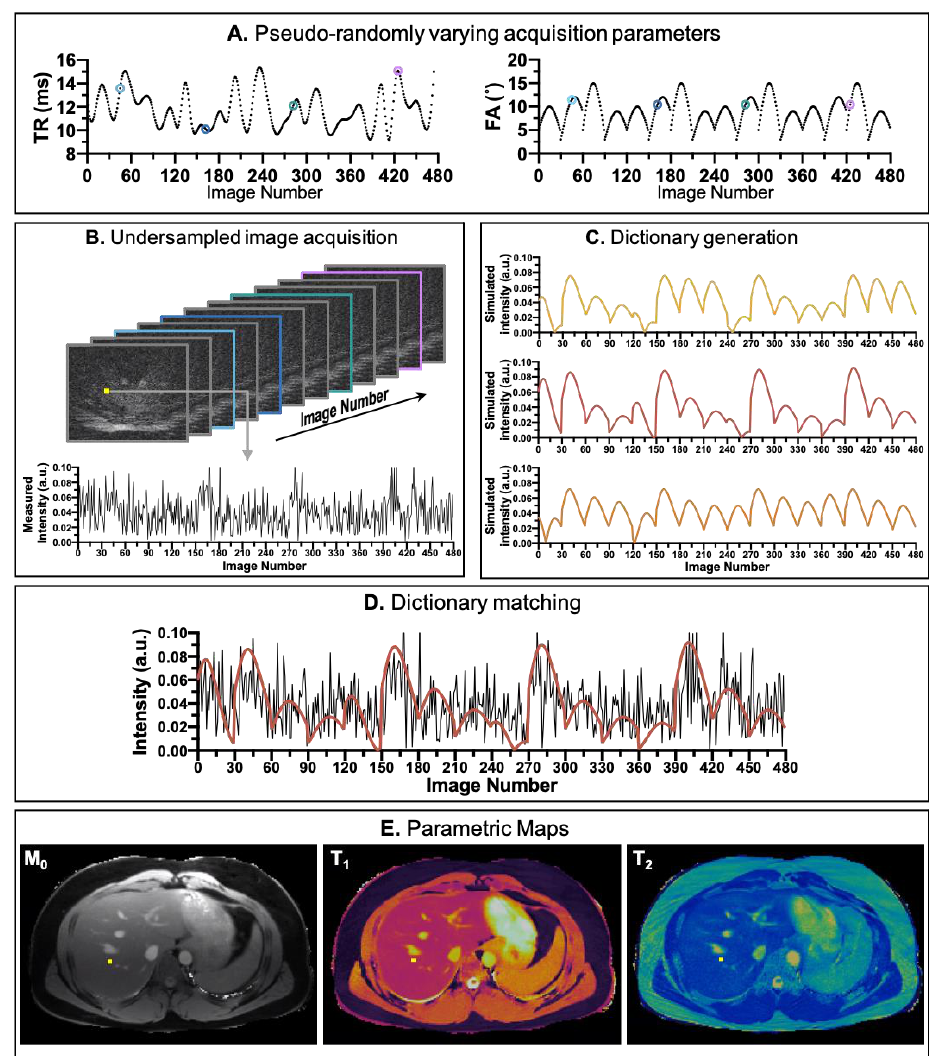
Figure 2. An overview of the MRF framework. ( A ) randomised series of repetition time (TR) and variable flip angles (FA) used for acquisition. ( B ) example of undersampled images acquired ( C ) example of dictionary entries ( D ) matching the temporal evolution of the signal measured with the dictionary ( E ) Abdominal MRF maps generated from the matching process with the dictionary.